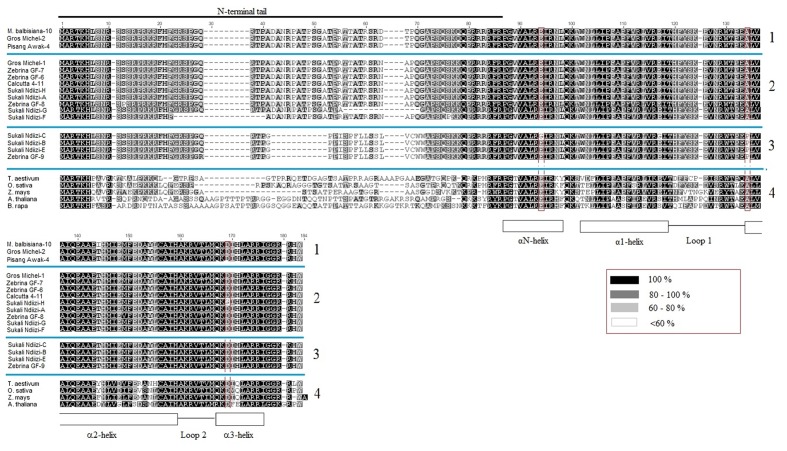
Multiple alignment of banana CENH3s. The blue lines separate the different alignments: Block 1 is a MusaCENH3-1A alignment, block 2 is a MusaCENH3-1B, block 3 is MusaCENH3-2 and block 4 is an alignment to other monocots and dicots. The red highlights in the alignment are some amino acids substitutions observed in banana alleles within the HFD. Inset red box is the similarity index. Alignments were conducted in ClustalW (Larkin et al., 2007) as implemented in Geneious version 7.1 (Kearse et al., 2012).